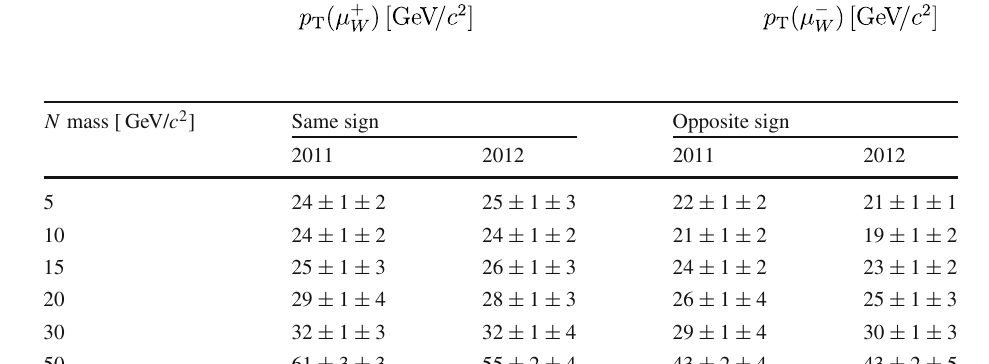
different heavy-neutrino masses, between normalisation and signal channels. The first uncertainty is statistical, the second is systematic